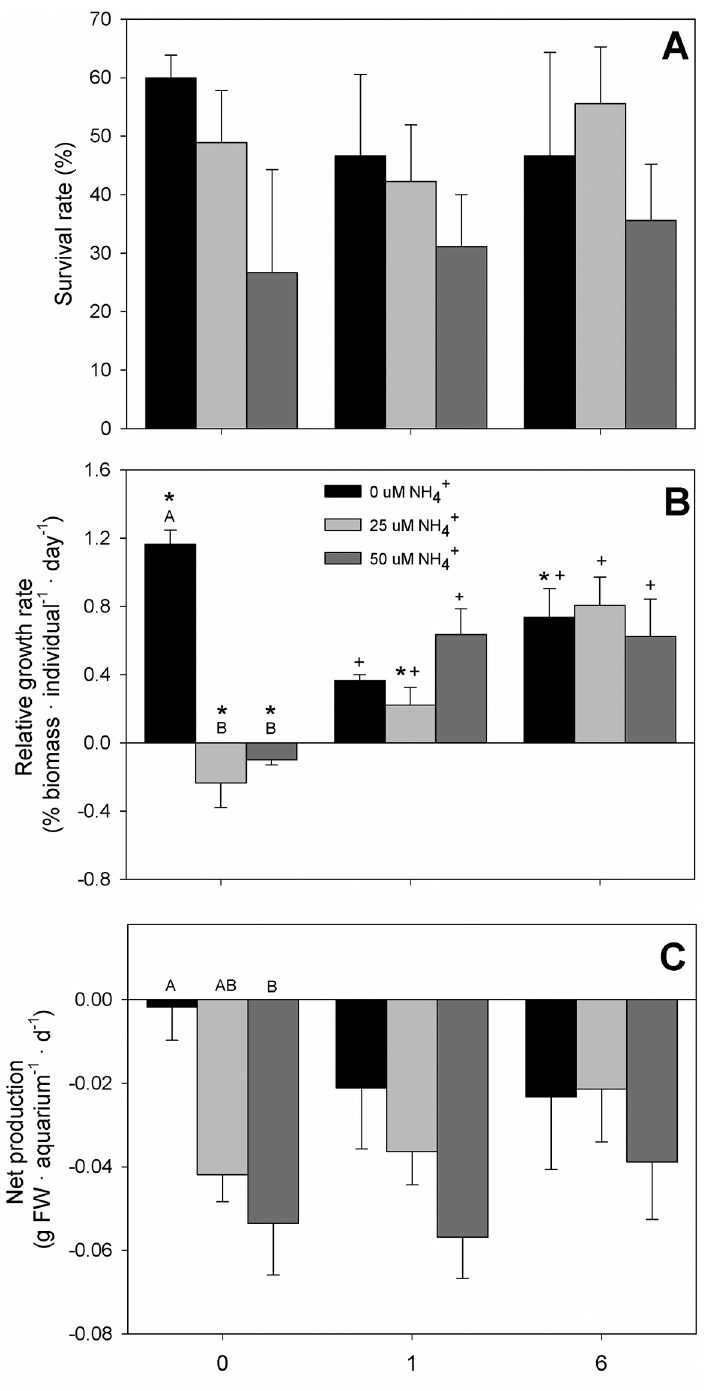
represent significant differences between Ulva sp. treatments with the same ammonium treatment. Data represent the mean ± SE (n = 3).